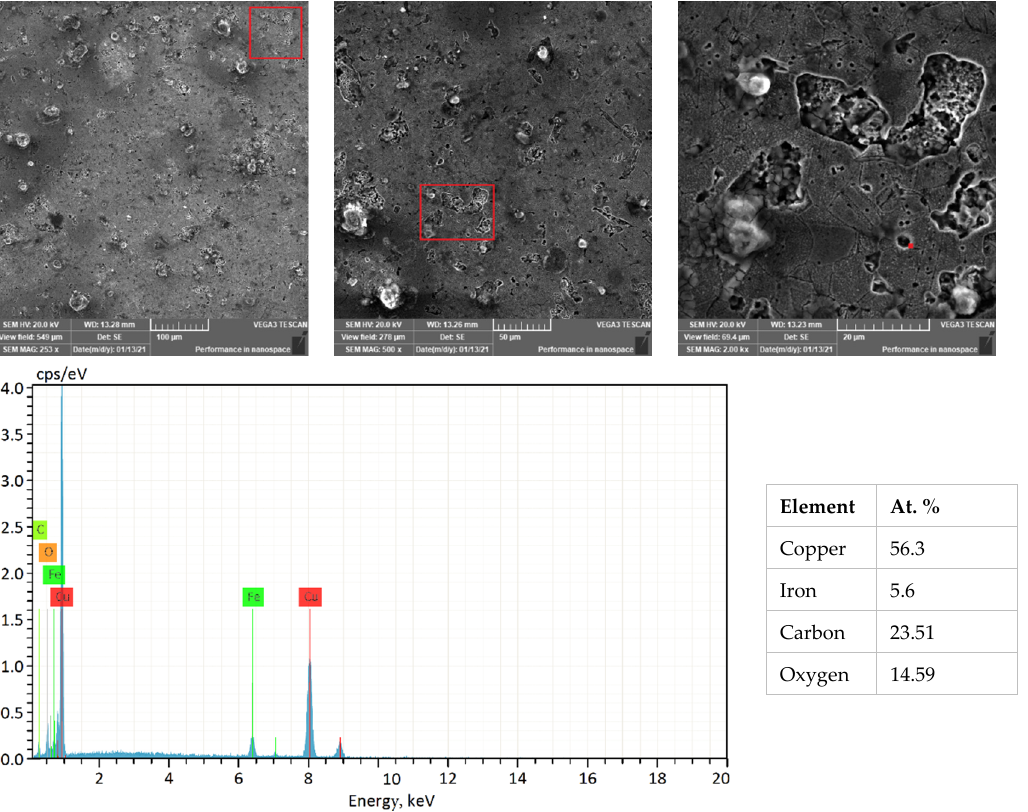
Figure 7 . SEM micrographs and the corresponding EDS analysis of the PW+SA sample at 200 MPa. Figure 7. SEM micrographs and the corresponding EDS analysis of the PW+SA sample at 200